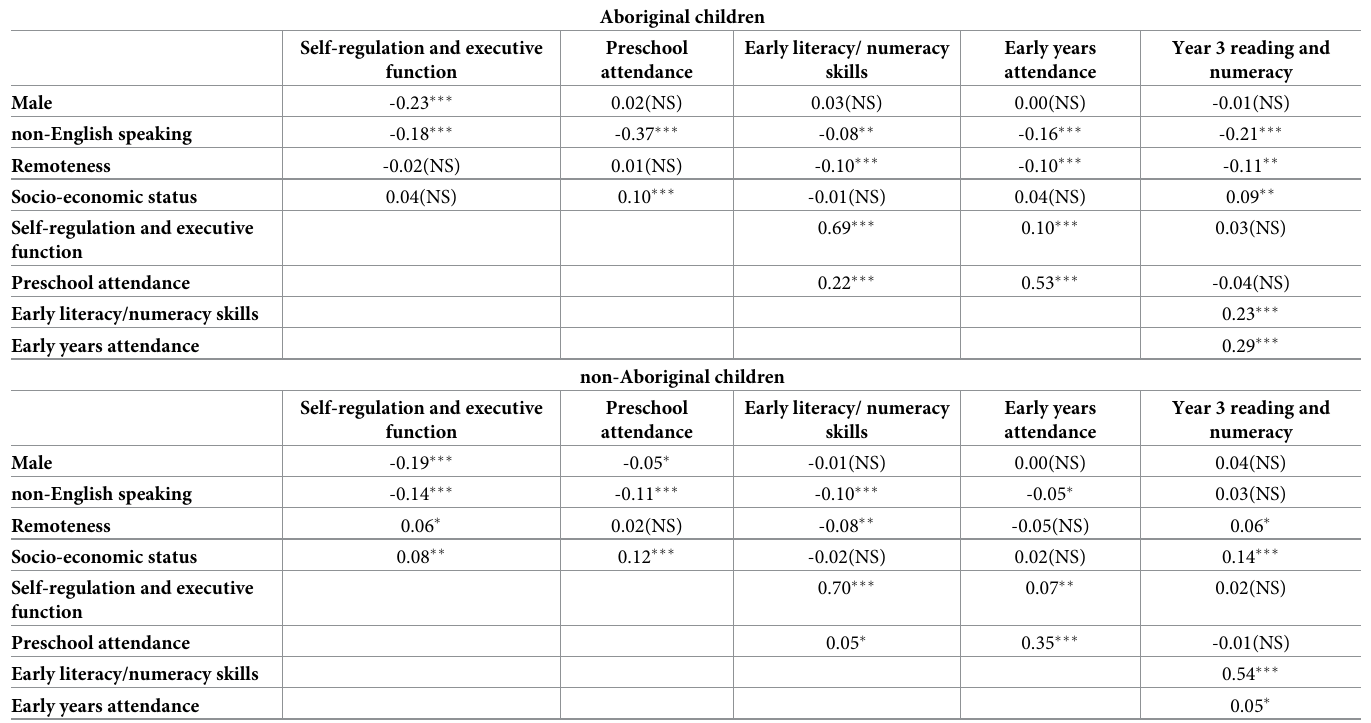
Table 3. Standardised beta coefficients from the structural equation modelling with Year 3 academic outcome (i.e. mediation